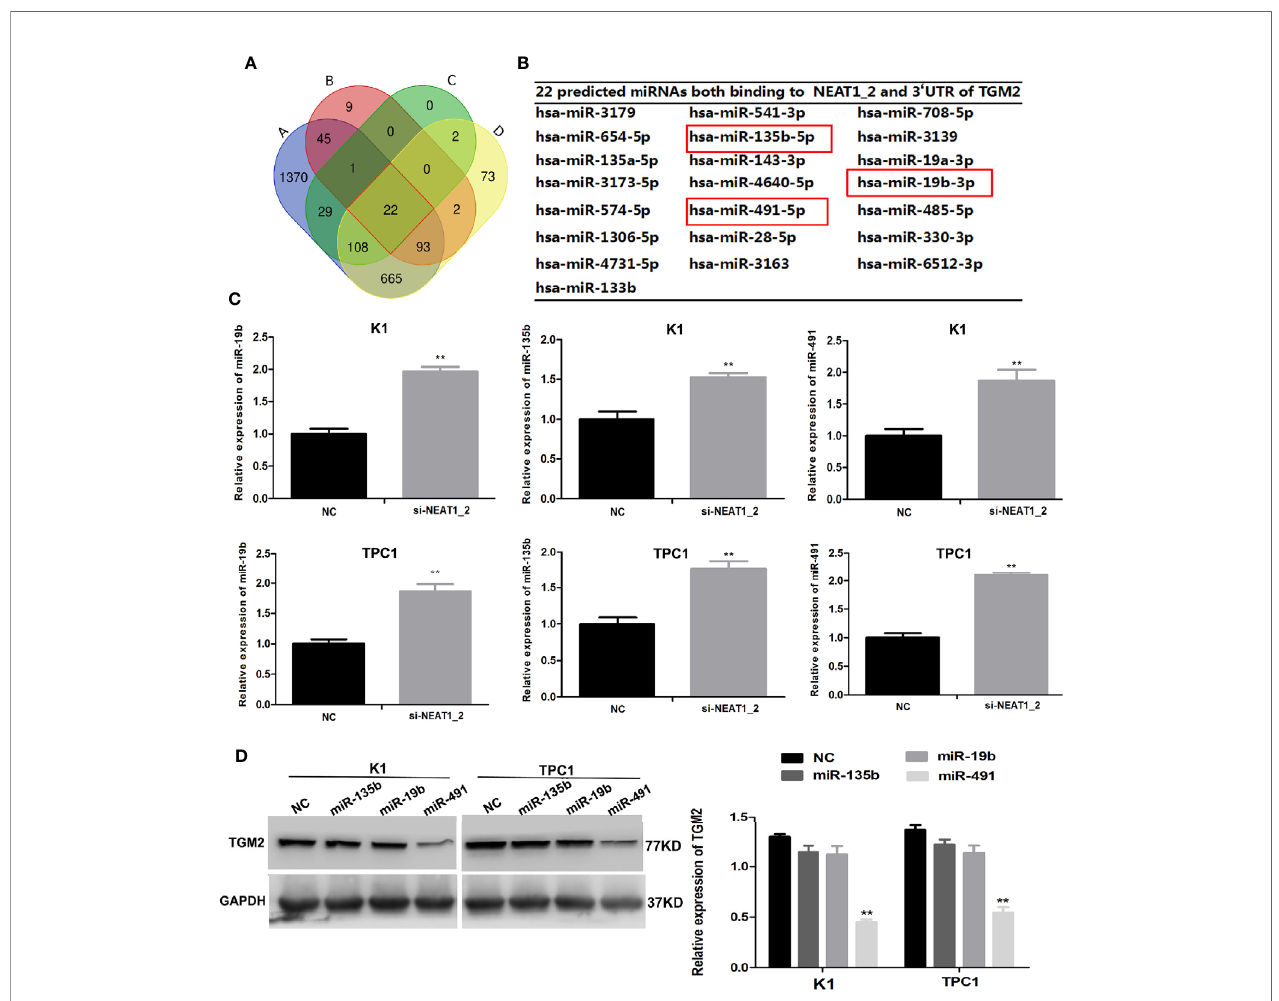
FIGURE 4 | NEAT1_2 regulates TGM2 via downregulating miR-491. (A) Identi fi cation of 22 common miRNAs that bind to both NEAT1_2 and TGM2 from four publicly available datasets (A: RegRNA 2.0, B: miRDB, C: Targetcan, and D: ENCORI). Different colored areas represent different datasets. (B) The 22 miRNAs that bind to both NEAT1_2 and TGM2 from bioinformatic prediction. (C) The relative expression levels of miR-19b, miR-135b, and miR-491 were detected using qRT- PCR in PTC cells transfected with si-NEAT1_2 or NC. Data are presented as the mean ± S.D., as analyzed using an independent samples t-test. **P < 0.01 versus NC. (D) Protein expression of TGM2 was detected using western blotting in PTC cells transfected with miR-19b mimic, miR-135b mimic, and miR-491 mimic or NC. Data are presented as the mean ± S.D., as analyzed using an independent samples t-test. **P < 0.01 versus